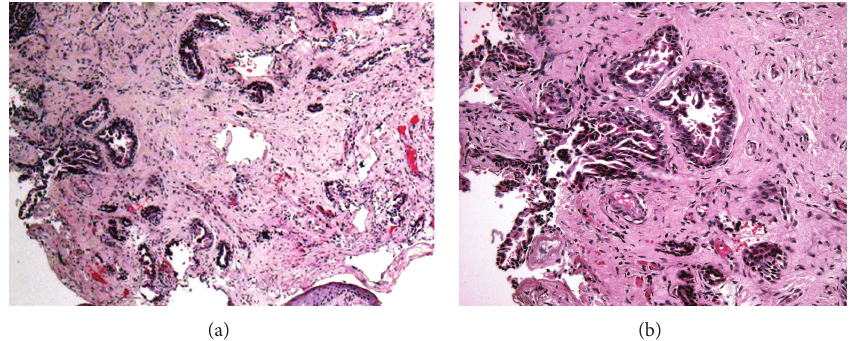
Figure 2: Histological appearance of the tumor, H&E stain. (a) Fragment of dermis with small irregular glands lined by a double-layered epithelium with micropapillary structures and focal squamous metaplasia. (b) Higher magnification of the tumor showing intraglandular micropapillary structures.